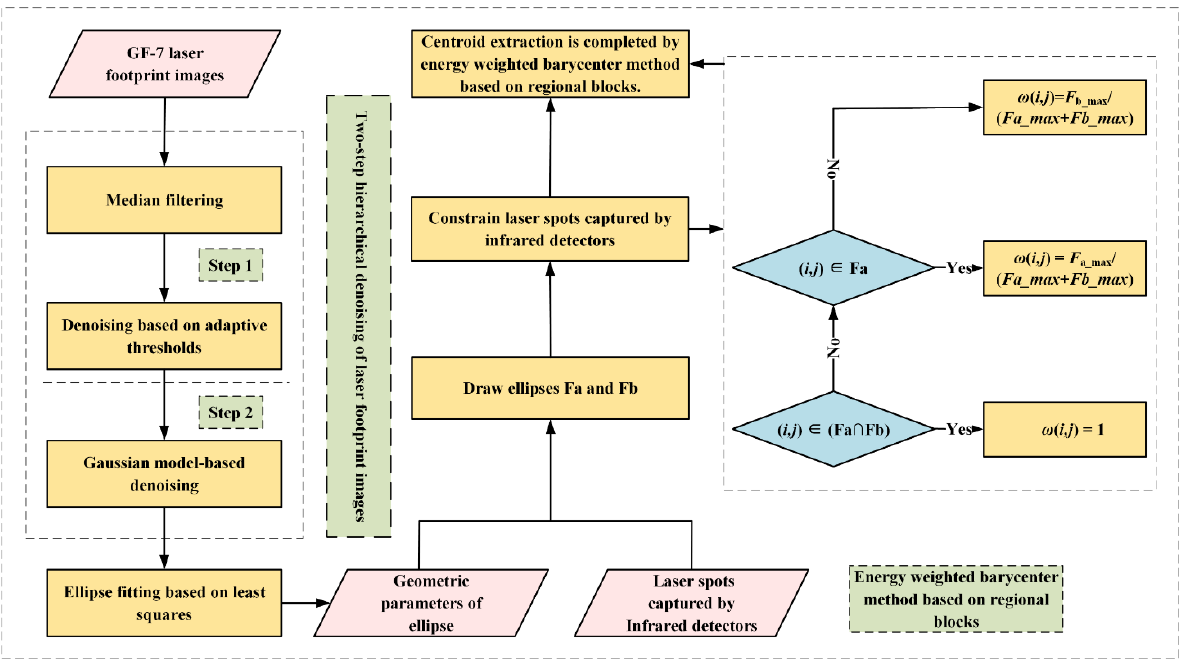
Figure 5. Centroid Extraction of Laser Spots Captured by Infrared Detectors Combining Laser Footprint Images and Detector Observation Data.